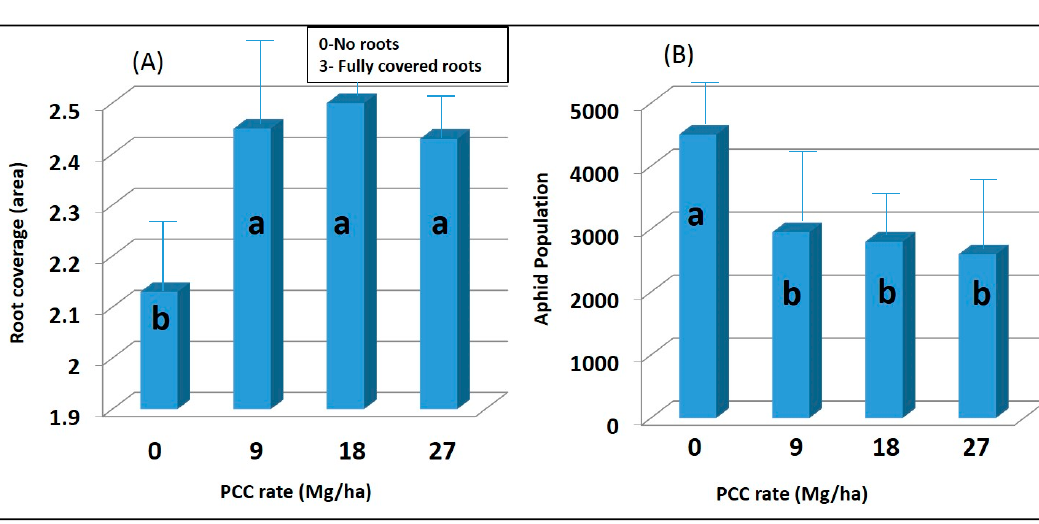
Figure 2. ( A ) Average root coverage rating (0–3) of sugar beet plants exposed to 0,9,18, and 27 Mg ha − 1 rates of precipitated calcium carbonate 6 weeks after seeding. Mean separation test (LSD) indicates that the mean values with the same letters are not significantly different at a 0.05 probability level. Note: Ratings: (0) No roots; (1) 1 to 2 roots filling the cell; (2) About 50% of cell space taken up by roots; (3) No visible empty space in cell (fully covered roots). (B) The average number of root aphids on sugar beet roots following exposure to 0,9,18, and 27 Mg ha − 1 rates of precipitated calcium carbonate. Mean separation test (LSD) indicates that the mean values with the same letters are not significantly different at a 0.05 probability level. Error bars indicate the standard error of the means.